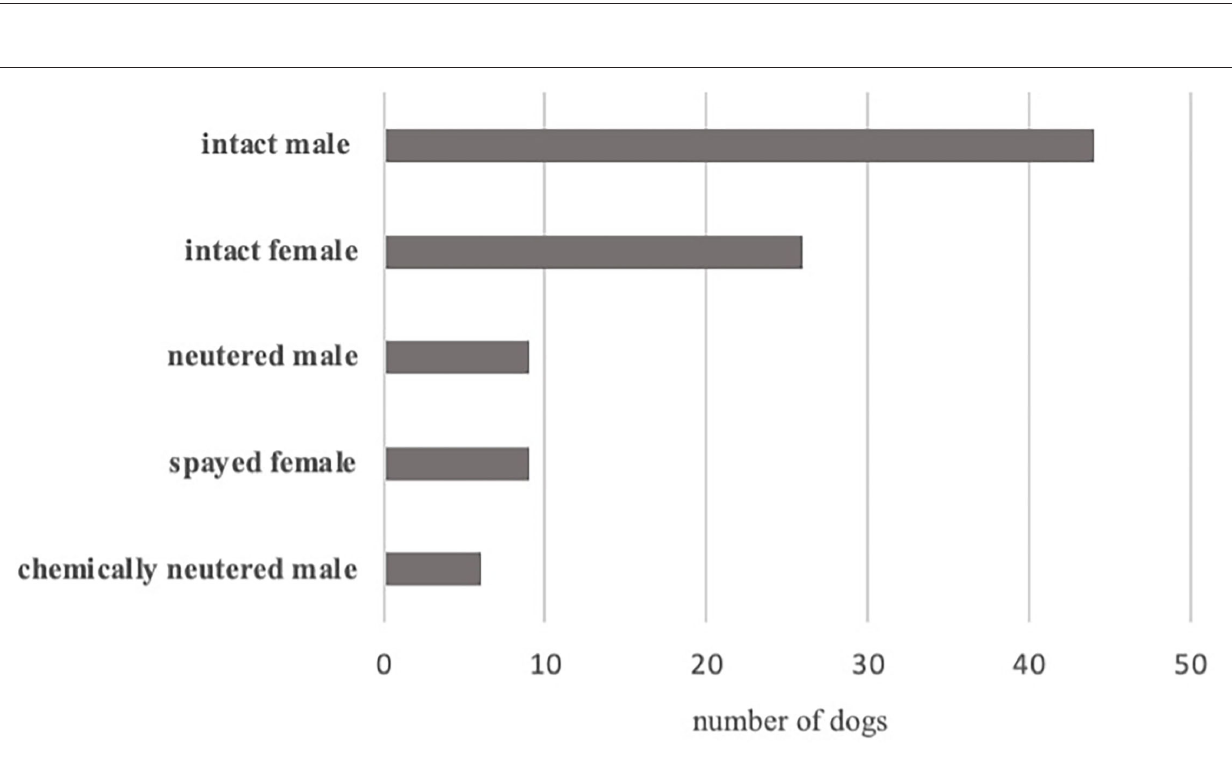
Frontiers in Veterinary Science |